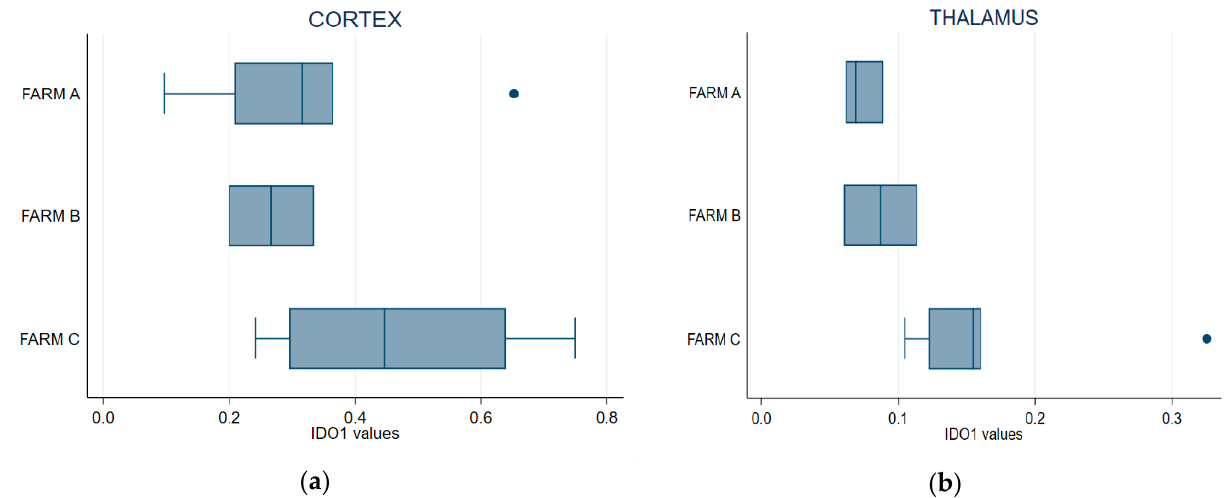
Figure 6. Box plot of IDO1 endogenous enzyme activity in the thalamus ( a ) and the cerebral cortex ( b ) samples. Error bars denote standard deviation.